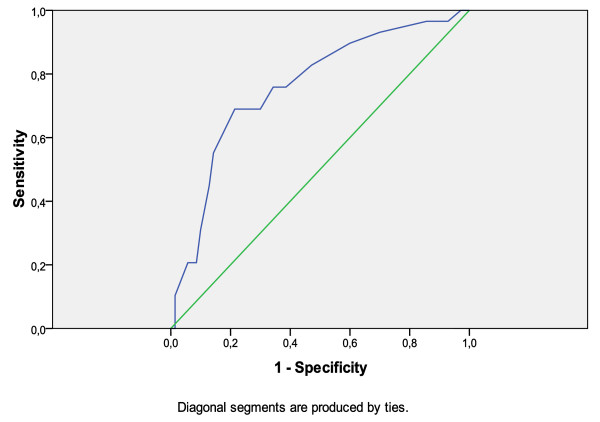
Receiving Operator Characteristic (ROC) curve of the SRQ-20 scores in the presence or absence of caseness as diagnosed by the clinicians.